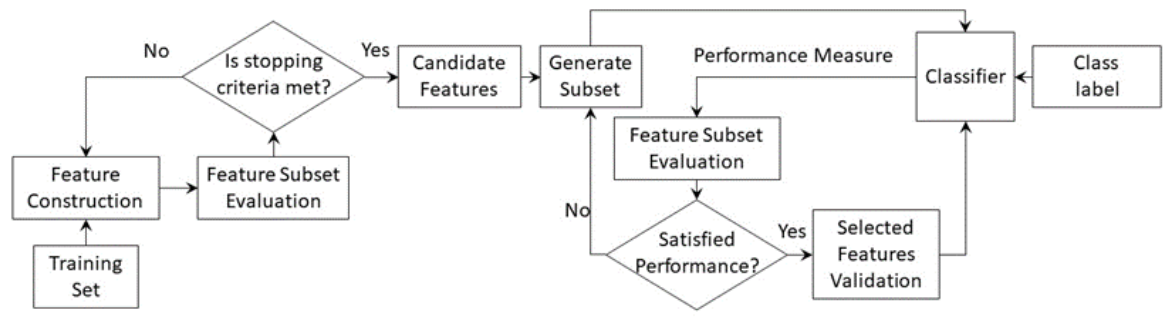
Figure 8. Hybrid technique framework used for feature selection.